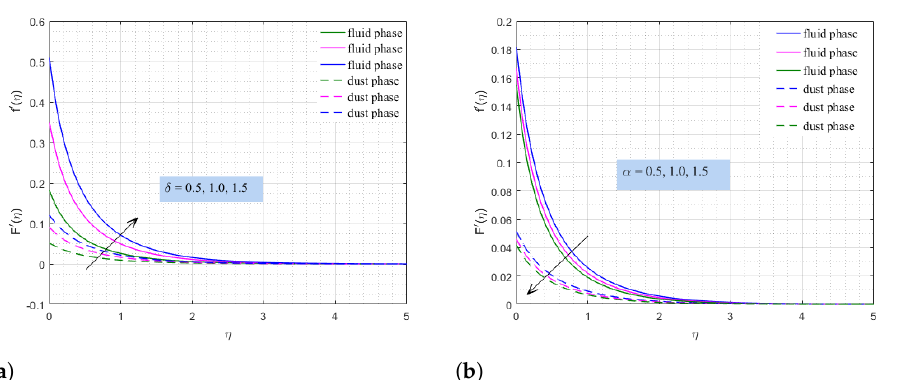
Figure 3. Change in the velocity profile at different values of certain parameters. ( a ) Change in velocity profile at different values of δ . ( b ) Change in velocity profile at different values of α .